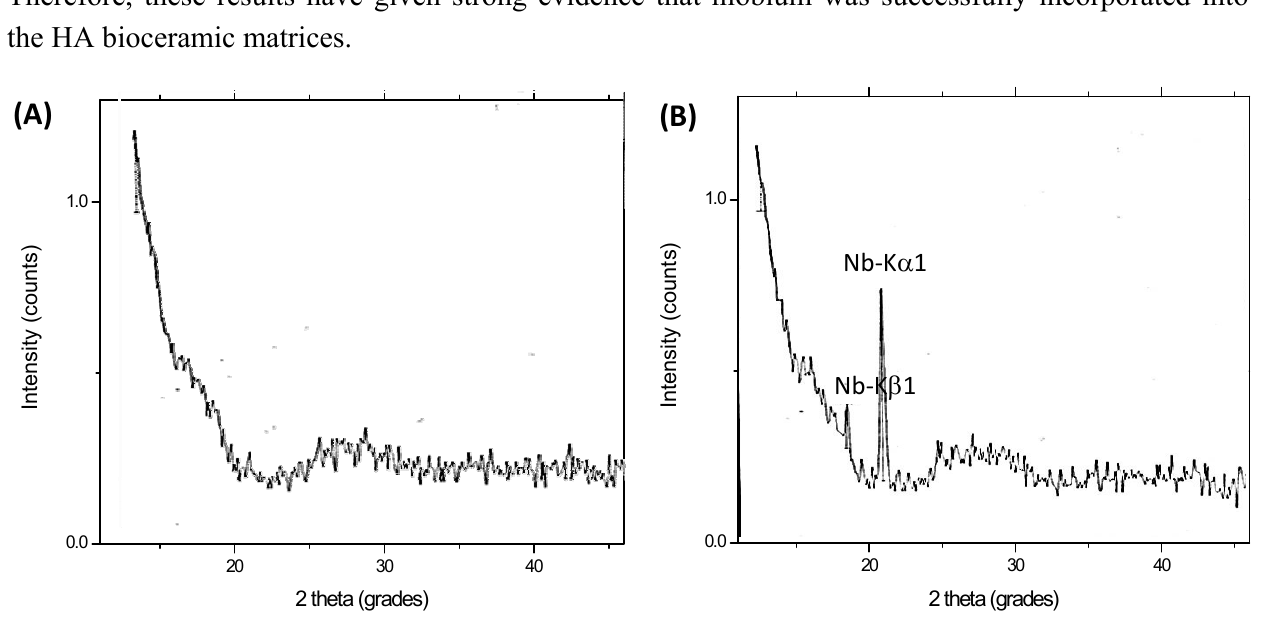
Figure 3. WD-XRF spectra of HA_900 ( A ) and Nb-HA_900 ( B